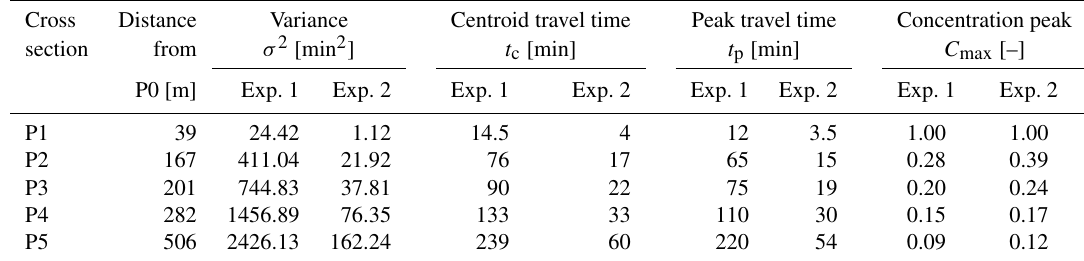
Table 2. Tracer data obtained for measured cross-sections (P1–P5) with (Exp. 1) and without (Exp. 2) vegetation. Cross